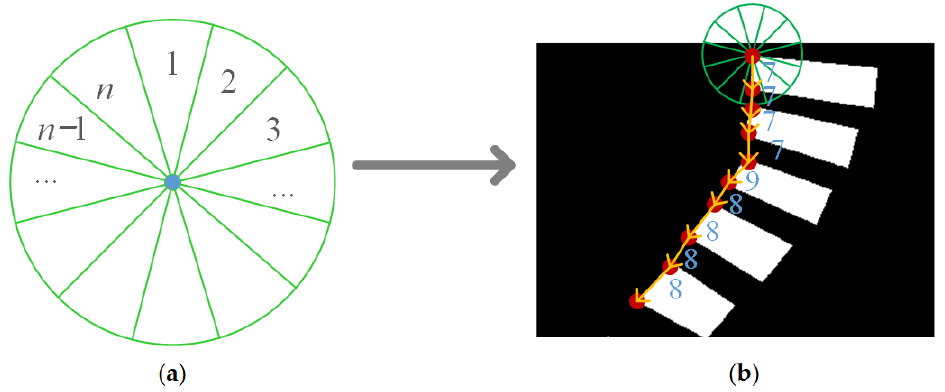
Figure 7. Outline representation using shape encoding. ( a ) Circular direction template; ( b ) outline representation of vertebrae.